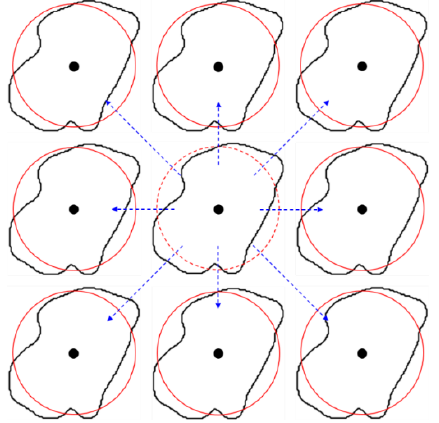
Figure 7. The results of the grain position change.